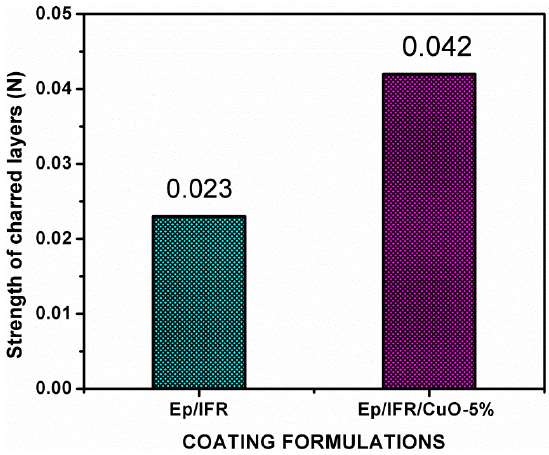
Figure 5. Strength analysis results of epoxy, Ep/IFR, and Ep/IFR/CuO-5% sample charred layers.